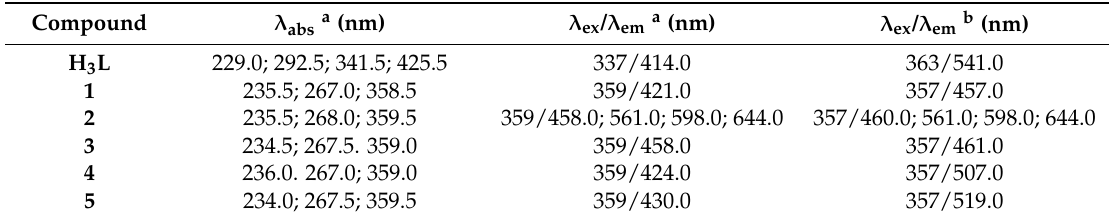
Table 2. Photophysical data of H 3 L and complexes 1 – 5